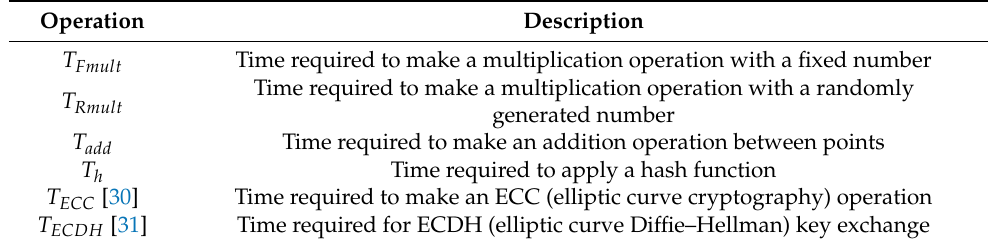
Table 4. Description of operations.